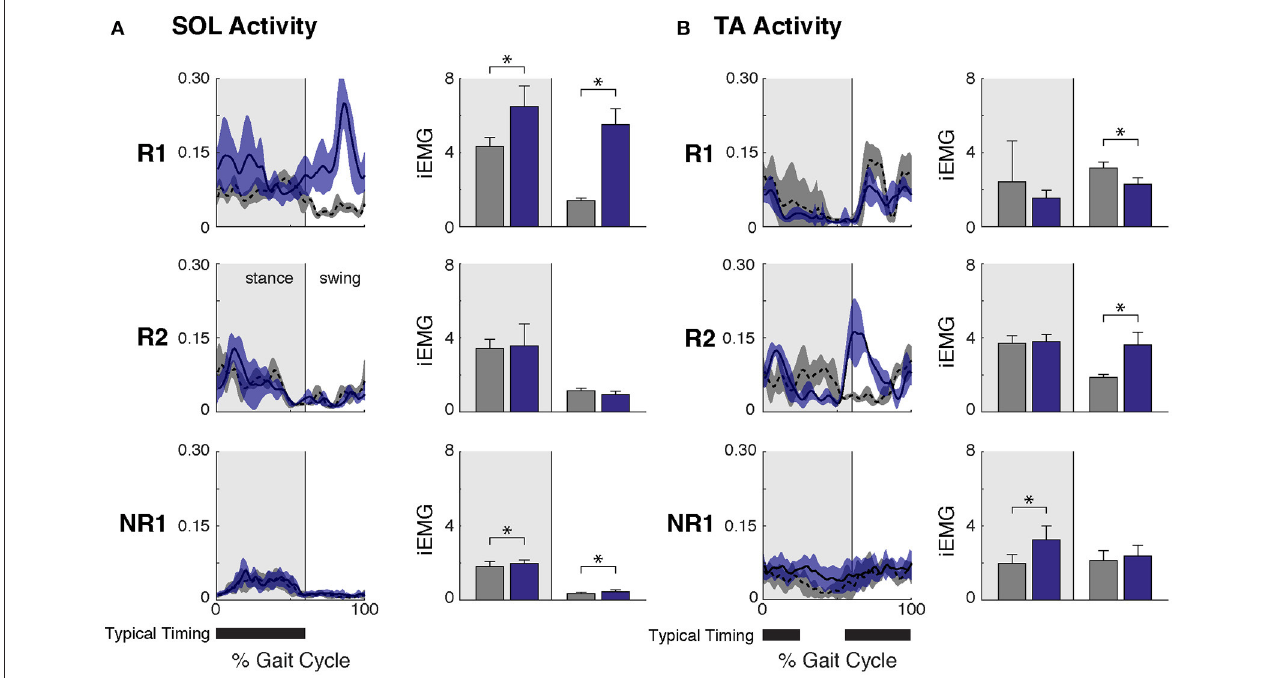
FIGURE 2 | Ankle muscle activity while walking at self-selected speed before and after FastFES. (A) Soleus (SOL) muscle activity across the gait cycle (left, average ± one standard deviation) and integrated SOL activity during stance and swing phases (right, where stance phase was defined as 0–60% of the gait cycle and swing phase as 61–100% of the gait cycle). After FastFES Participant R1 demonstrated increased SOL recruitment during stance, and Participants R1 and NR1 had increased SOL activity during swing. (B) Tibialis anterior (TA) muscle activity across the gait cycle (left, average ± one standard deviation) and integrated TA activity during stance and swing phases (right). After FastFES, Participant R1 decreased TA activity during swing, Participants R2 increased TA activity during swing, and Participant NR1 had increased TA activity during stance. Note that to prevent the influence of changes in speed on muscle activity, post-training trials were selected with speeds matched to the pre-training self-selected walking speed. The average walking speeds across pre-training SSWS trials in participants R1, R2, and NR1 were 0.78 ± 0.07 m/s, 1.60 ± 0.20, and 0.47 ± 0.04, respectively, and for post-training at matched speeds were 0.75 ± 0.03 m/s, 1.70 ± 0.09, and 0.43 ± 0.02, respectively (* denotes p ≤ 0.05). Typical timing is from Perry